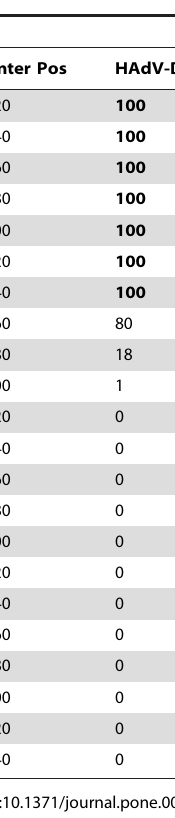
Table 3. An excerpt from the plot values of a Simplot Bootscan of the HAdV-22D and HAdV-D37